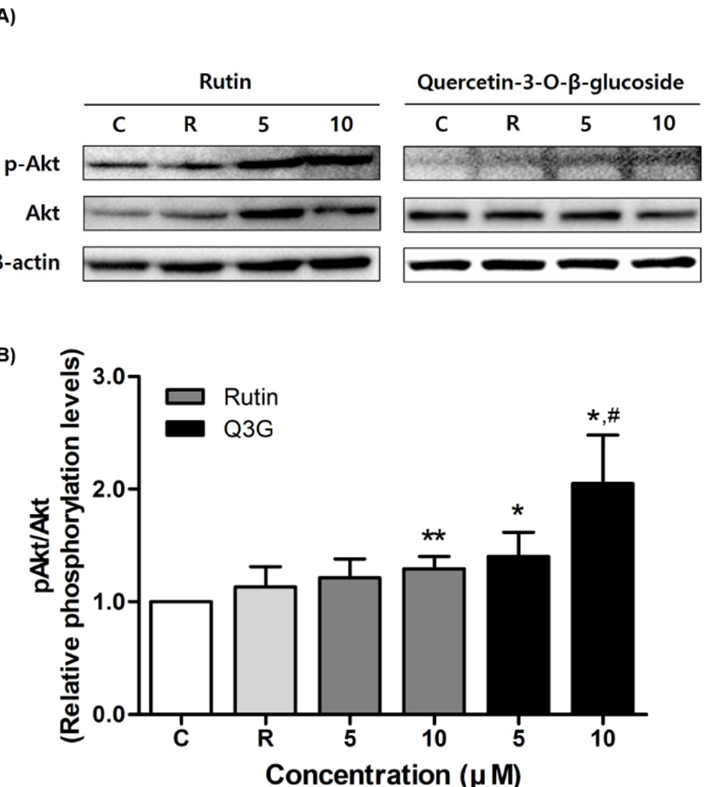
Figure 4. Effect of rutin and quercetin-3- O - β - D -glucoside (Q3G) on Akt phosphorylation in insulin- stimulated 3T3-L1 adipocytes. ( A ) Representative Western blots of Akt and phosphorylated (phospho-Akt). ( B ) Quantification of relative phosphorylation levels of Akt. Levels of phospho-Akt were normalized to total Akt for each compound. Data are means ± standard error of the mean (SEM, n = 3); * p < 0.05 and ** p < 0.01 versus control. # p < 0.05 versus rosiglitazone 10 µ M. C, control; R, rosiglitazone 10 µ M.